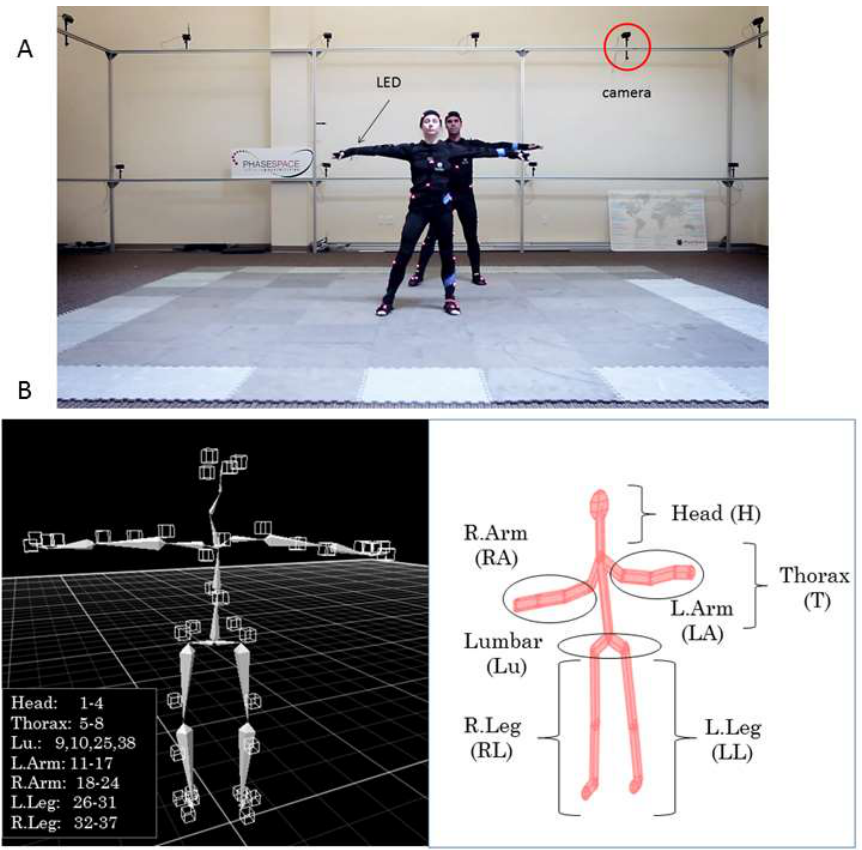
Figure 2. The data collection and representation tools. ( A ) Two professional dancers in T-pose while being calibrated within the Phase Space. Cameras capturing the motion are marked and suits contain 38 LEDs in each dancer’s body. Data is sampled at 960 Hz. ( B ) ( Left ) panel: Skeleton showing the distribution of LEDs from 1–38 across the body segments. ( Right ) panel: Our avatar designed in Matlab using a forward kinematics model in [32] to track the various parameters of interest (see movie from the Phase Space and Bot and Dolly in Link 1 of the Appendix.).